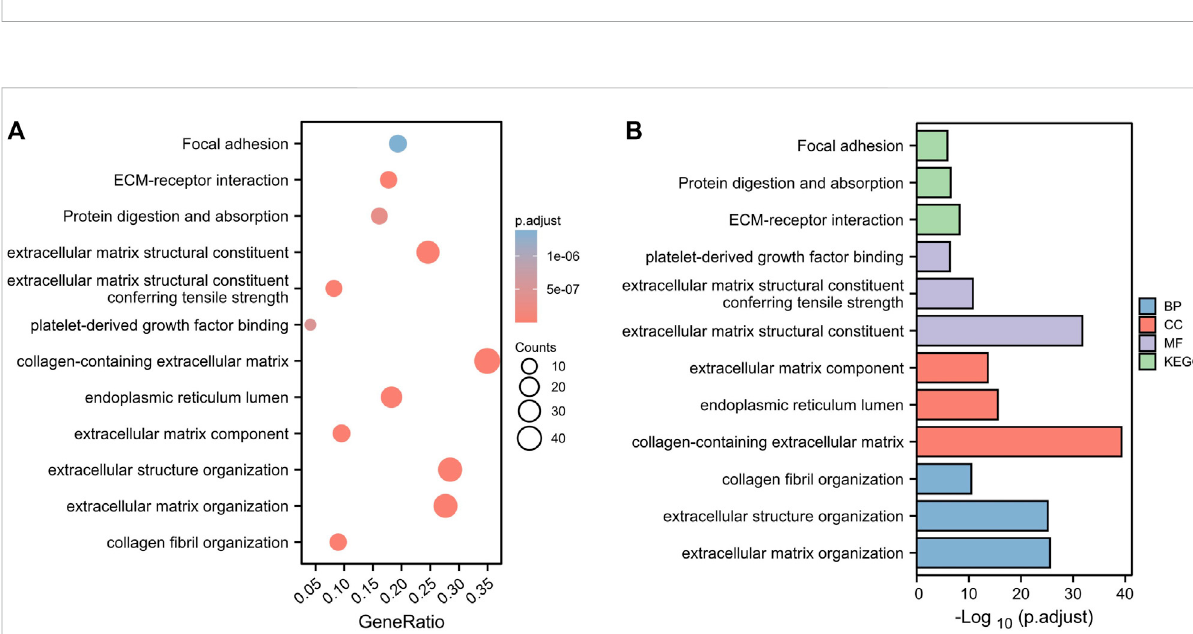
FIGURE 6 Development and veri fi cation of a nomogram. (A) Nomogram for one-, three-, and 5-year OS. (B) Calibration curves.